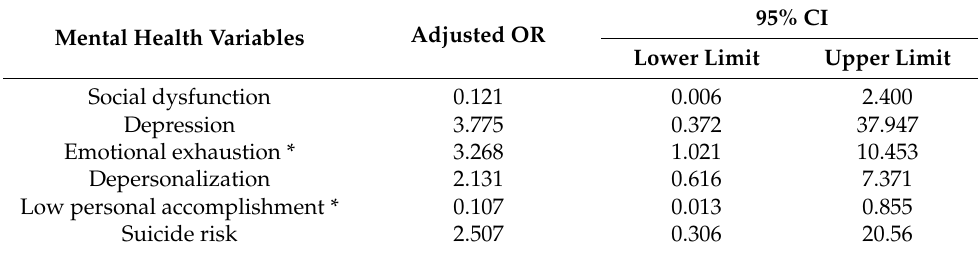
Table 6. Mental health risk factors for job